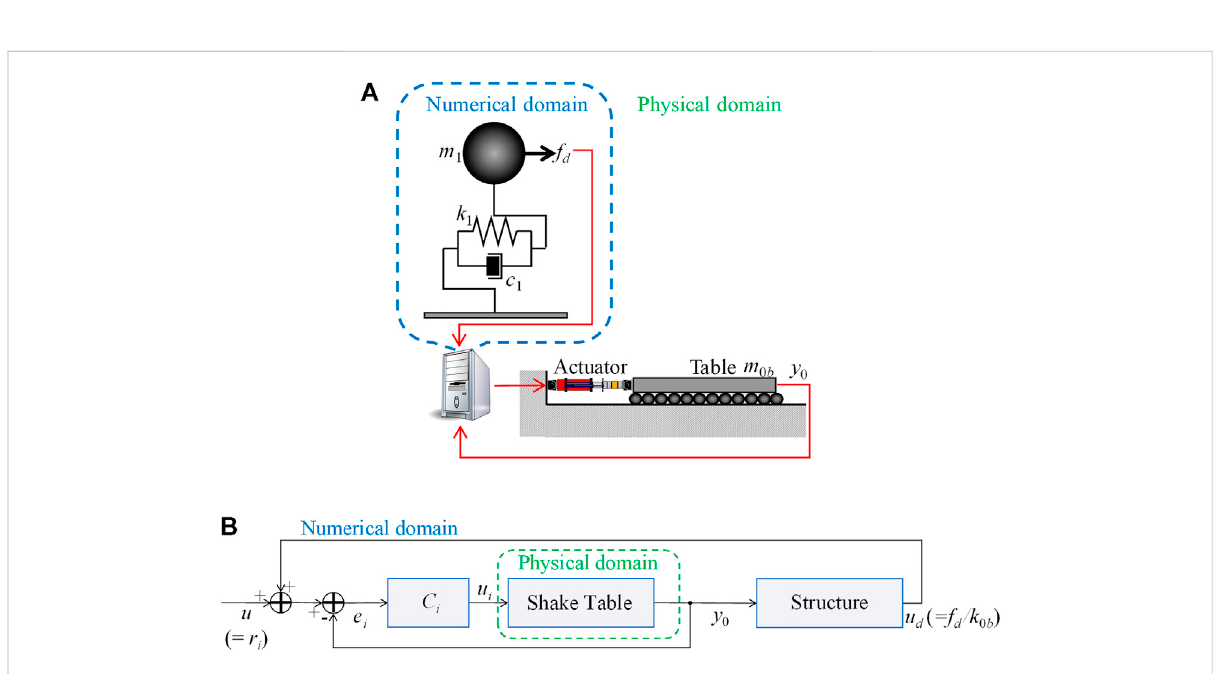
FIGURE 3 Numerically disturbed shake table experimentation: (A) conceptual drawing, and (B) block